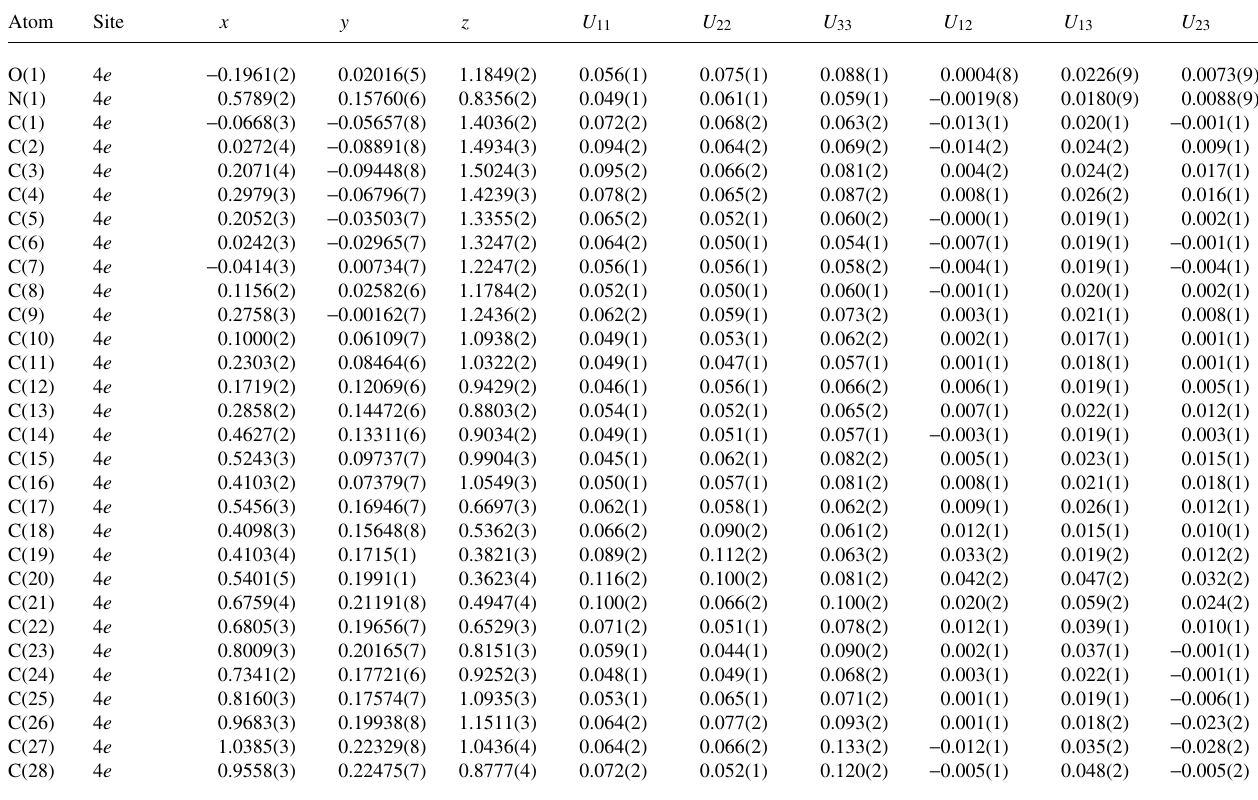
Table 3. Atomic coordinates and displacement parameters (in Å 2 )